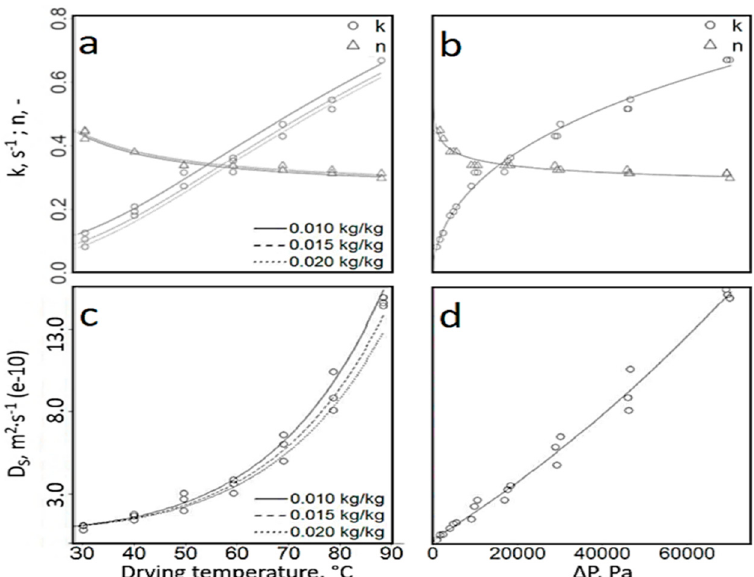
Figure 3. Parameters k , n , and the fitted models from ( a ) Equations (10) and (10a) for k , n = f ( T , x ) in ◦ C and kg · kg − 1 and ( b ) modeled with Equation (11) and (11a) for k , n = f ( ∆ P ) in Pa . ( c ) D S = f ( T , x ) for temperature from 30 ◦ C to 90 ◦ C and absolute humidity of the drying air of 0.010, 0.015, and 0.020 kg · kg − 1 modeled with Equation (12) and ( d ) D S = f ( ∆ P ) for the same temperature and humidity range, modeled with Equation (13).